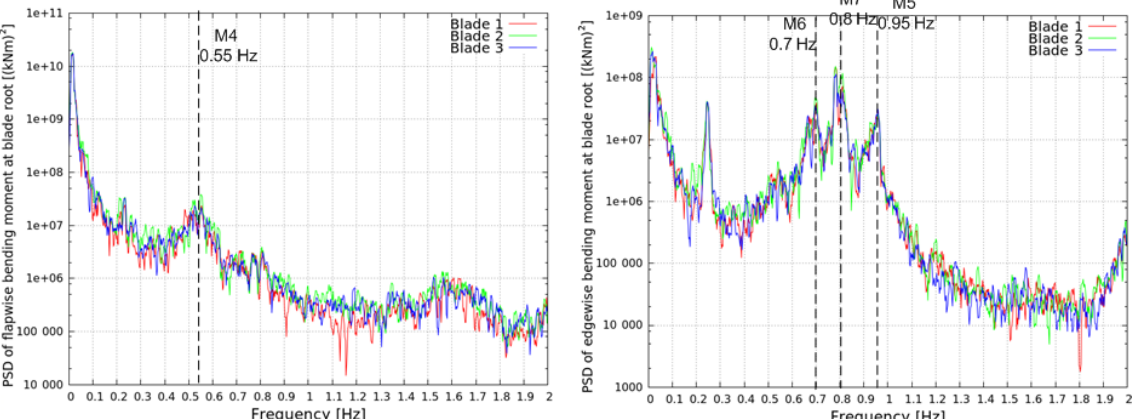
Figure 20. (a) PSD of the flapwise bending moment at the blade root and (b) PSD of the edgewise bending moment at the blade root; U = 42 . 5ms − 1 and yaw = 30 ◦